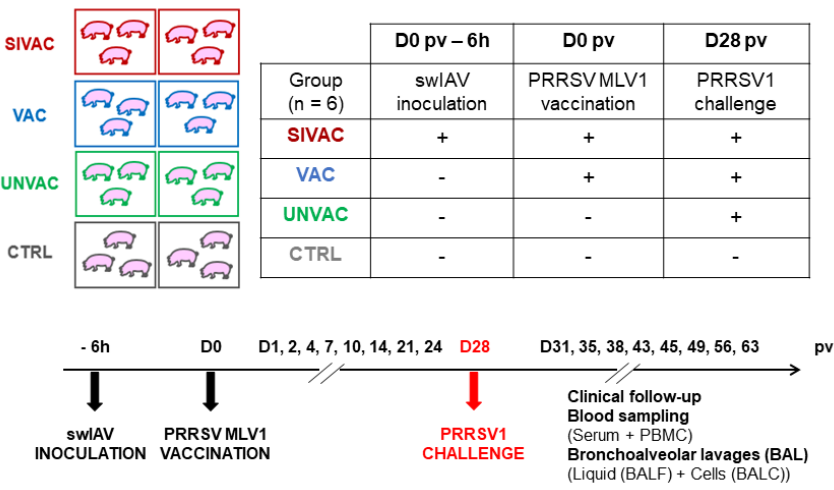
Figure 1. Description of the experiment design.